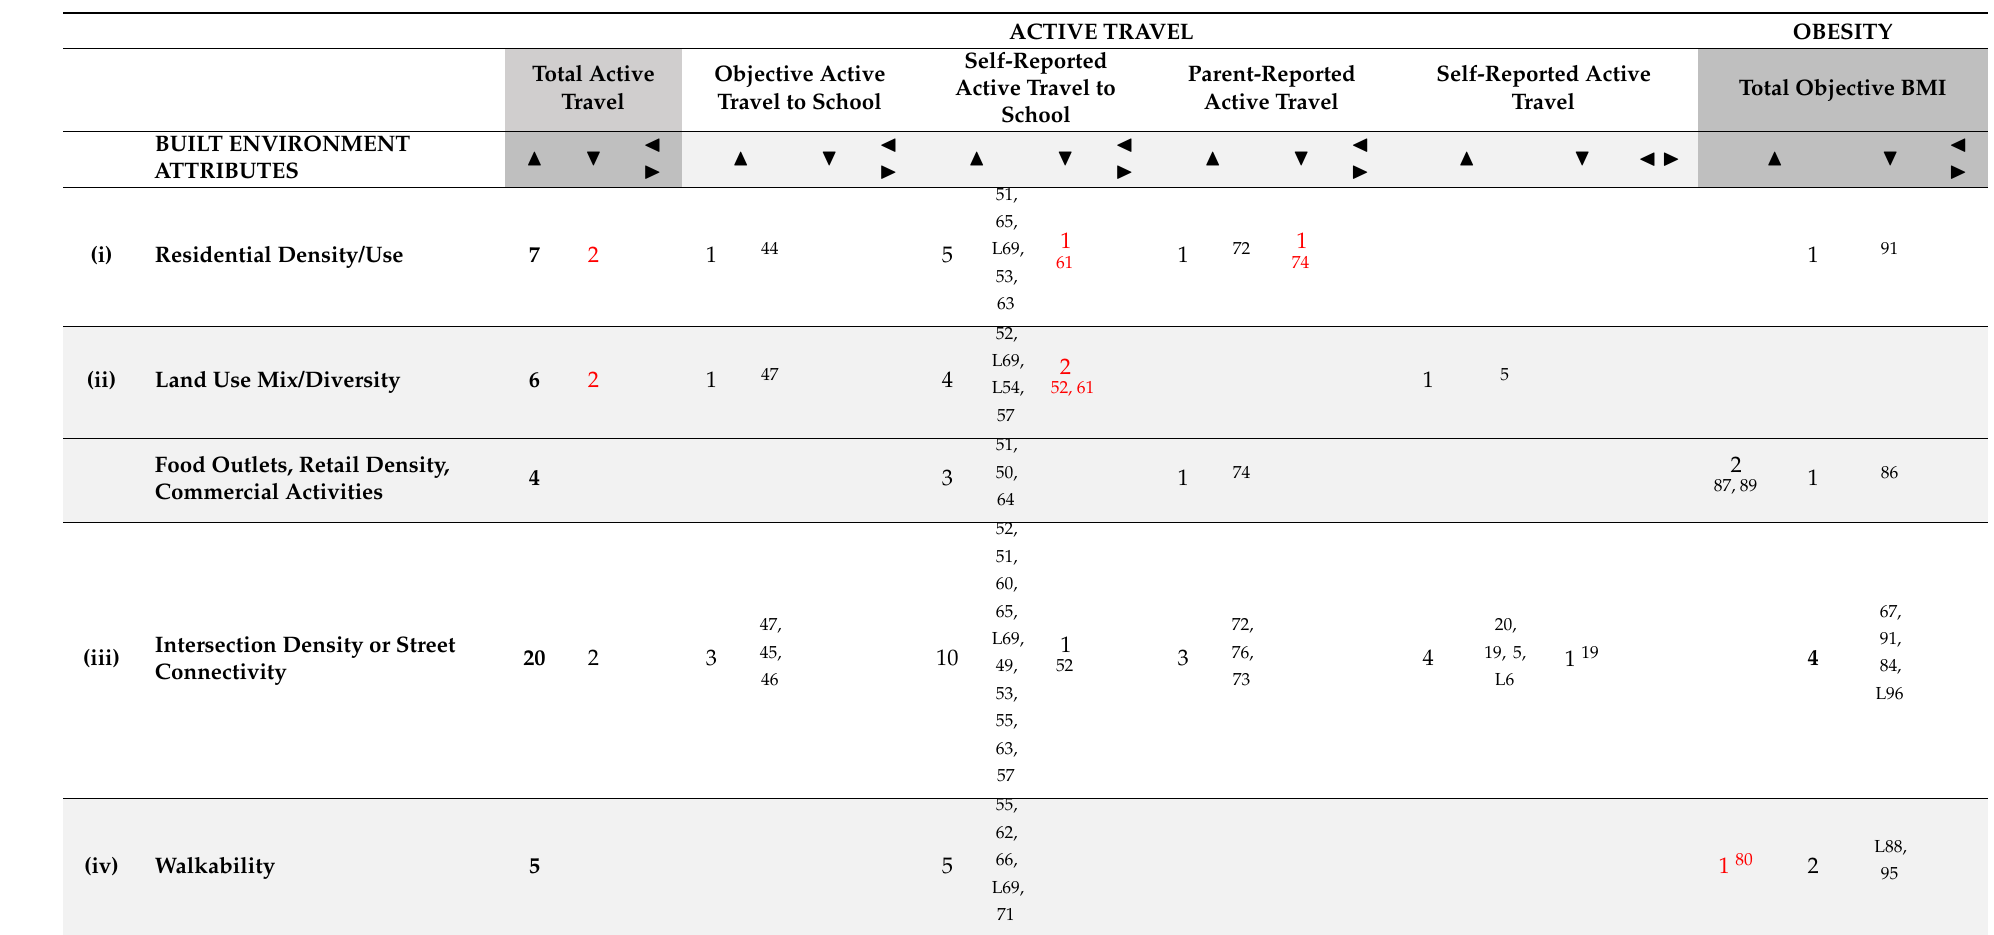
Table 4. Built environment and active travel or obesity